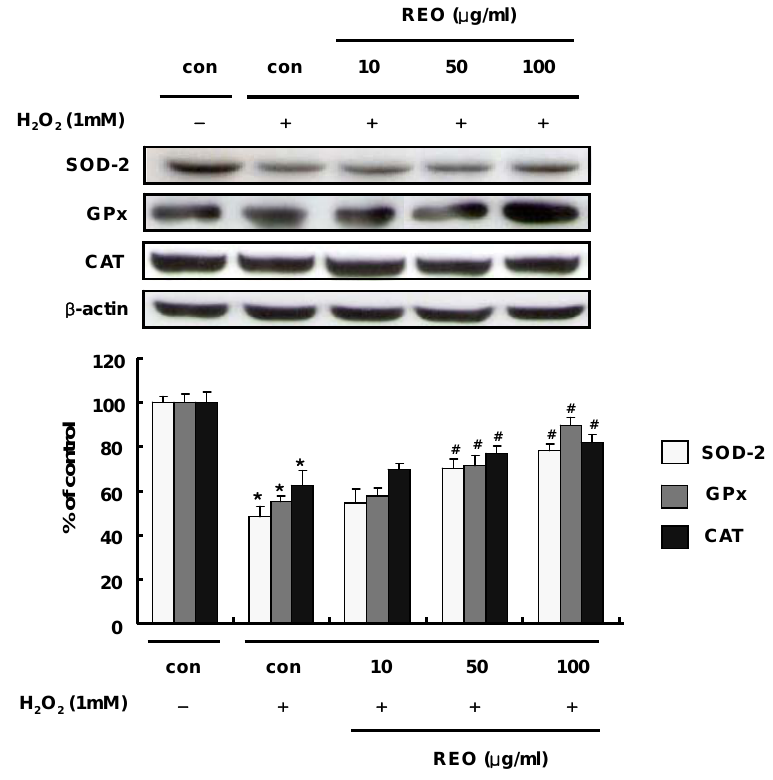
Figure 3. Effects of REO on SOD, GPx and CAT protein expressions in HepG2 cells. The bands shown are representative of three independent experiments with similar results. Values are means ± SD; n = 3. * p < 0.05, significantly different from the